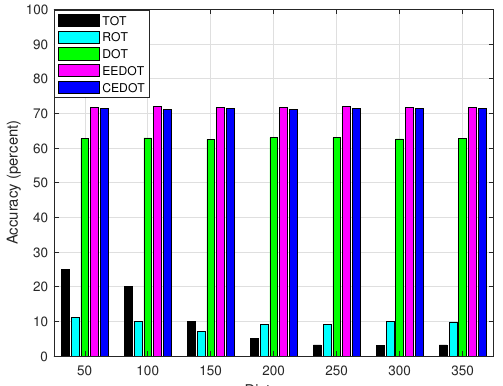
Figure 8. Comparison of the DNN accuracey with respect to